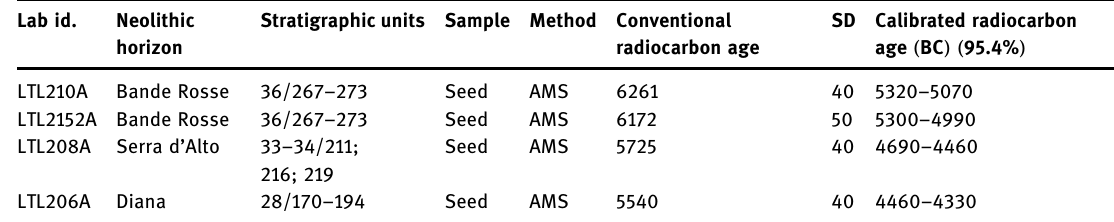
Table 1: Radiocarbon dates from Grotta San Michele Arcangelo di Saracena. All dates have been calibrated with the OxCal 4.3 software ( Bronk Ramsey, 2009 ) using the IntCal13 curve ( Reimer et al., 2013 ) Lab